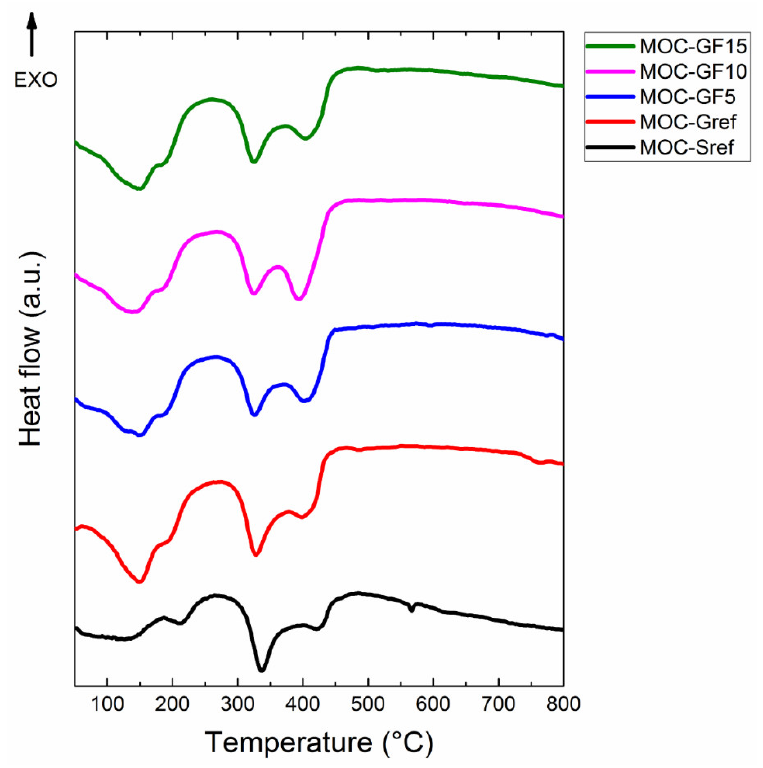
Figure 7. DTA curves of prepared composites measured in dynamic air atmosphere.